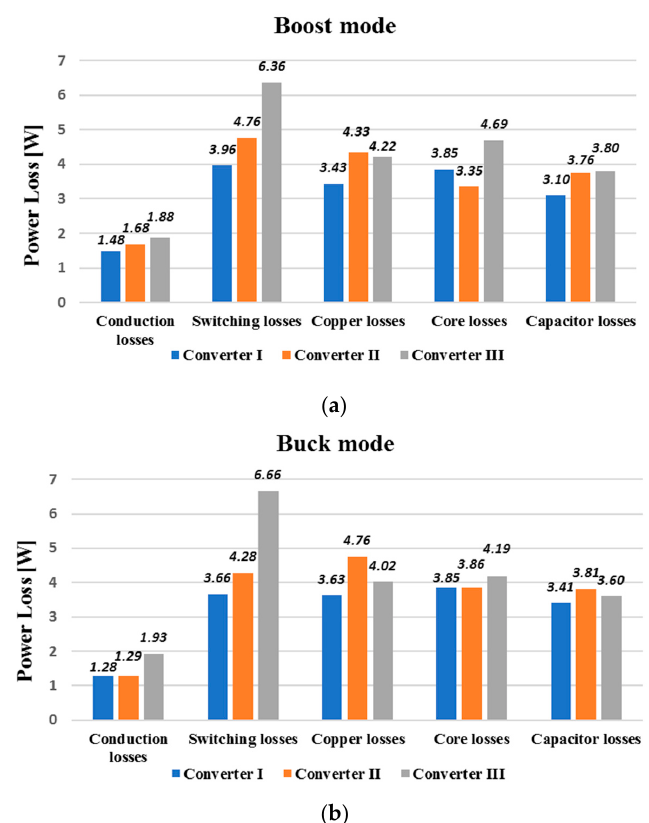
Figure 20. Calculated power loss distributions with U low = 120 V, U high = 250 V, and P o = 200 W: ( a ) boost mode and ( b ) buck mode.